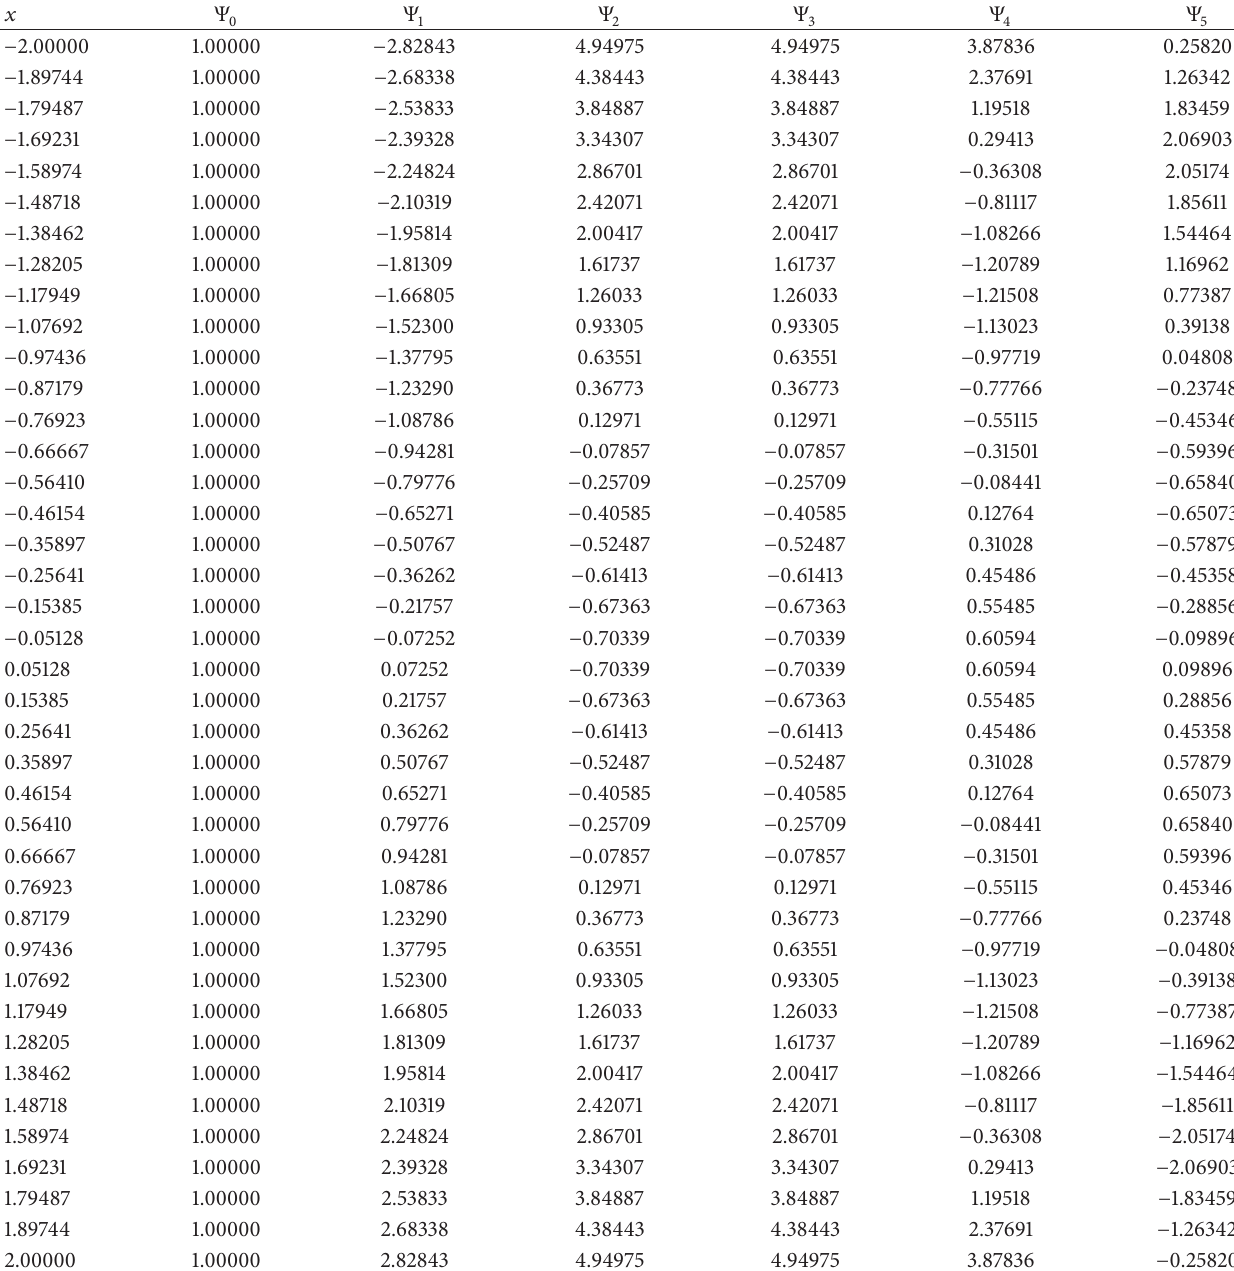
Table 21: Evaluation of first six orthonormal Hermite polynomials on the vector 𝑥 of 40 equally spaced points from −2 to 2